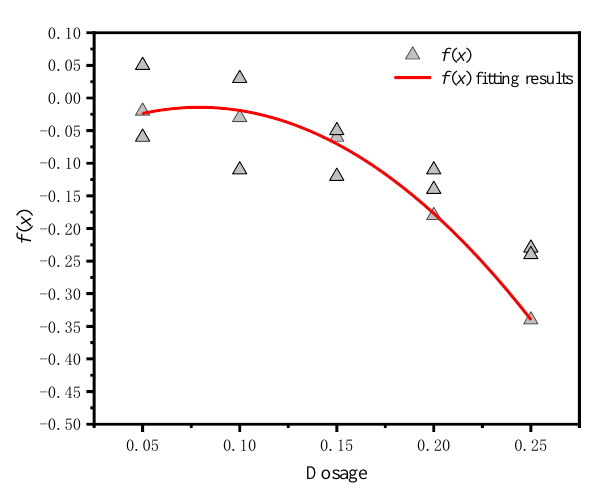
Figure 18. f ( x ) fitting results.